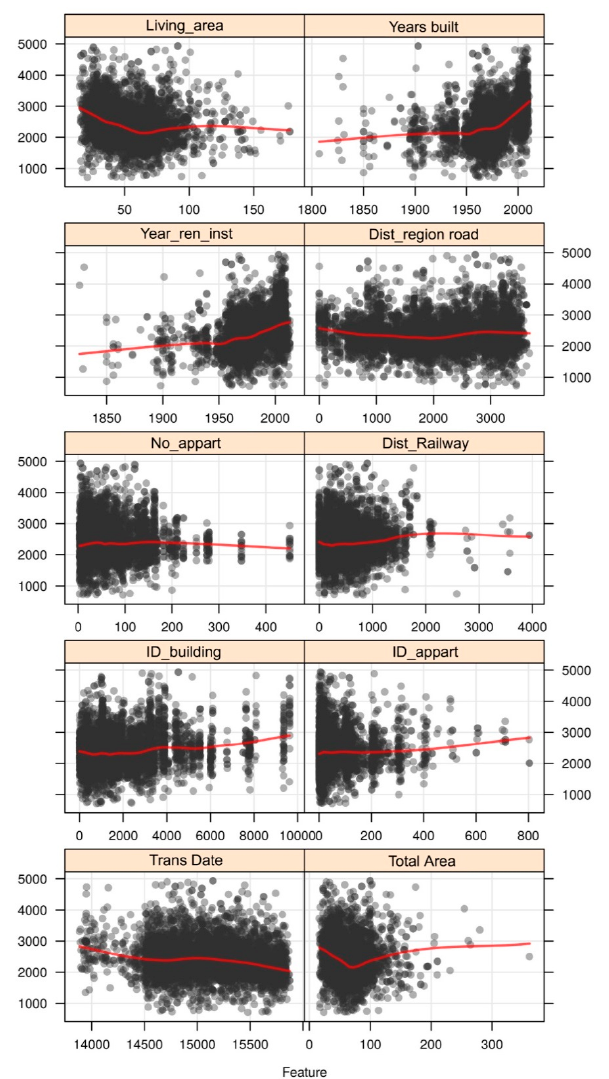
Figure 3. The scatter plots of predictor values versus price/m 2 values.